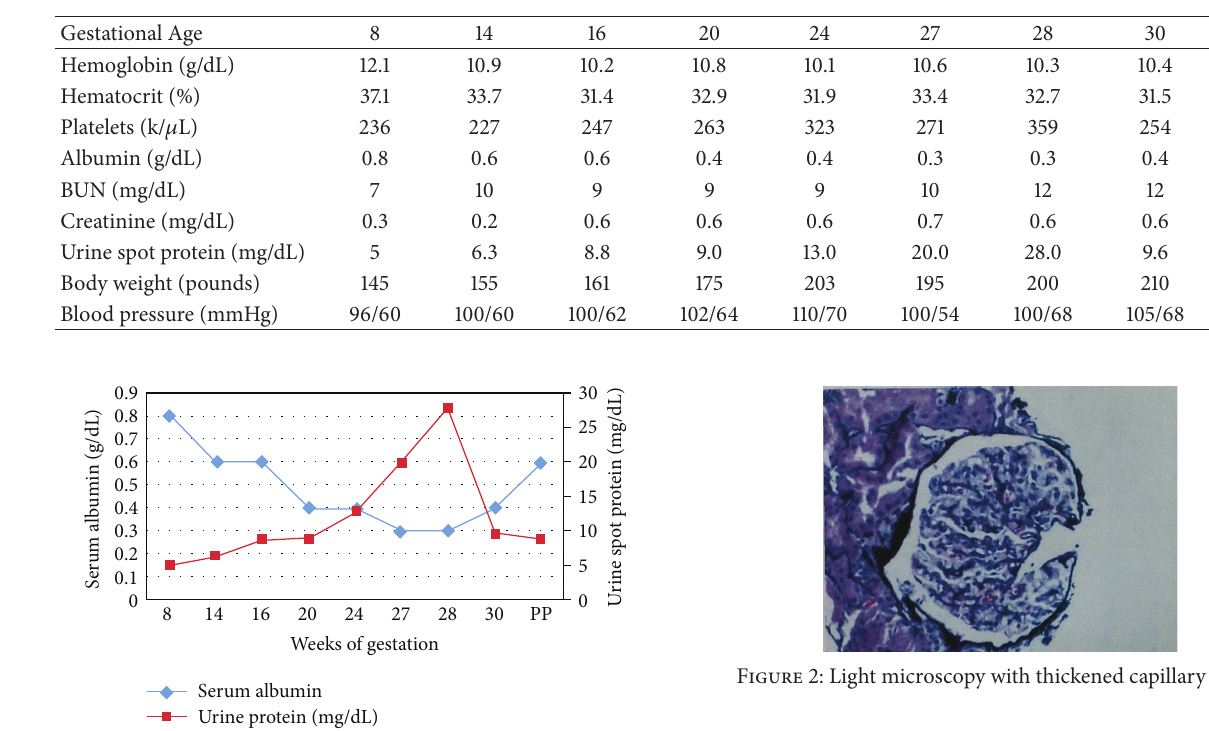
Table 1: Laboratory values, body weight, and blood pressure during pregnancy.